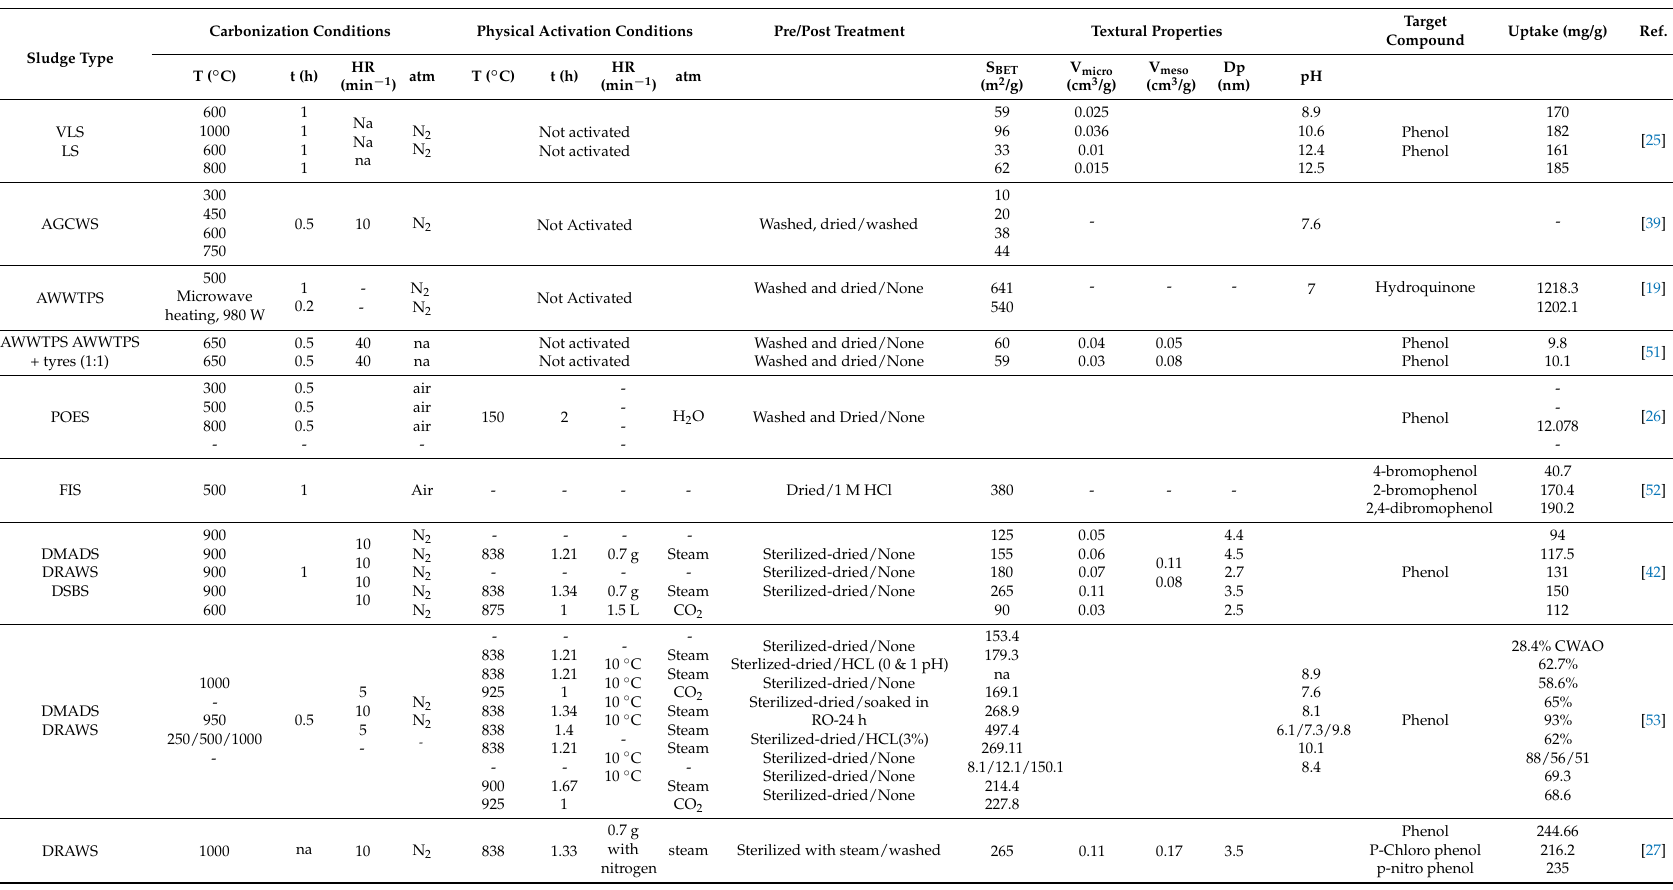
Table 3. Properties of Sludge-based Activated Carbon produced from thermal/physical treatment methods for PC